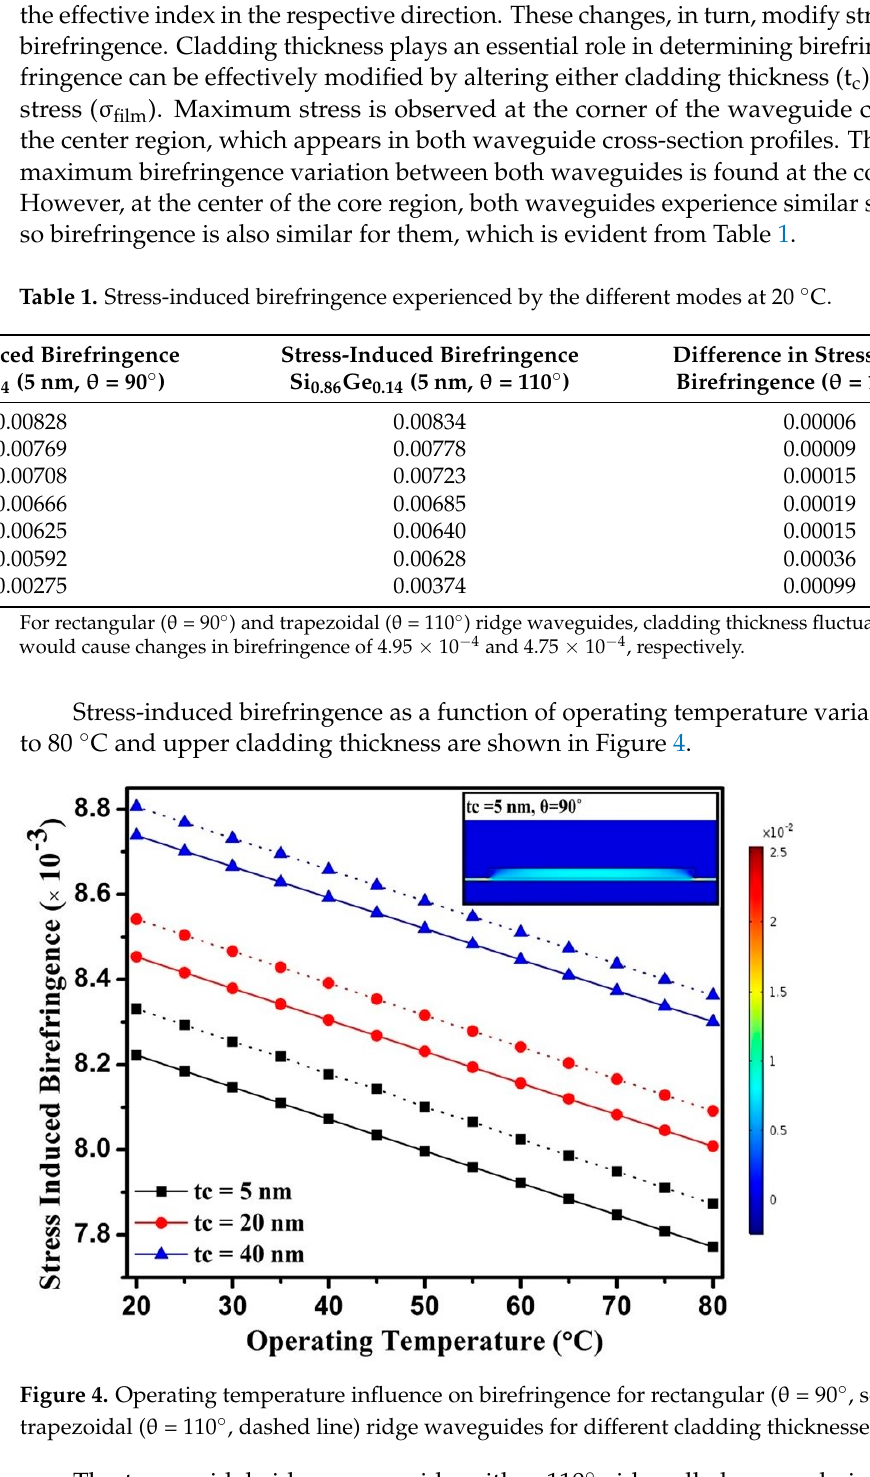
Table 1. Stress-induced birefringence experienced by the different modes at 20 °C. Mode No.